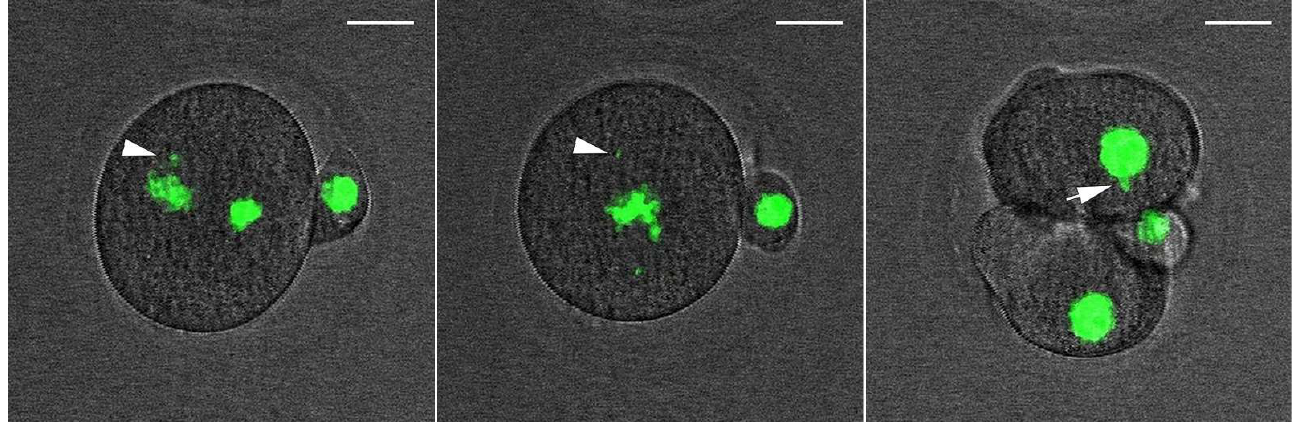
Figure 6. Quantification of the total volume of DNA in control and NCS-treated one-cell embryos. The graph shows the relativized values of the measured fluorescent signal densities.